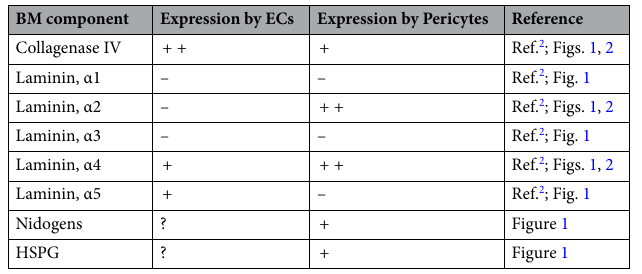
Table 1. A summary of the primary islet BM components expression